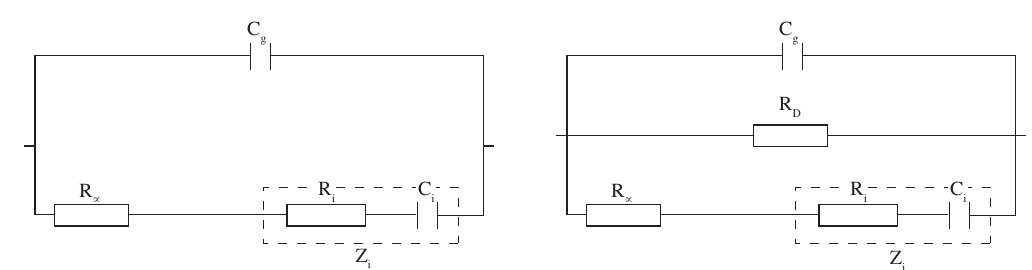
Fig. 3. Equivalent circuit that represent the sample in the low saturation case ( C g and R ∞ are the capaci- tance and resistance of the sample at the high fre- quency, respectively, C i is the interfacial capacitance and R i is the interfacial resistance).